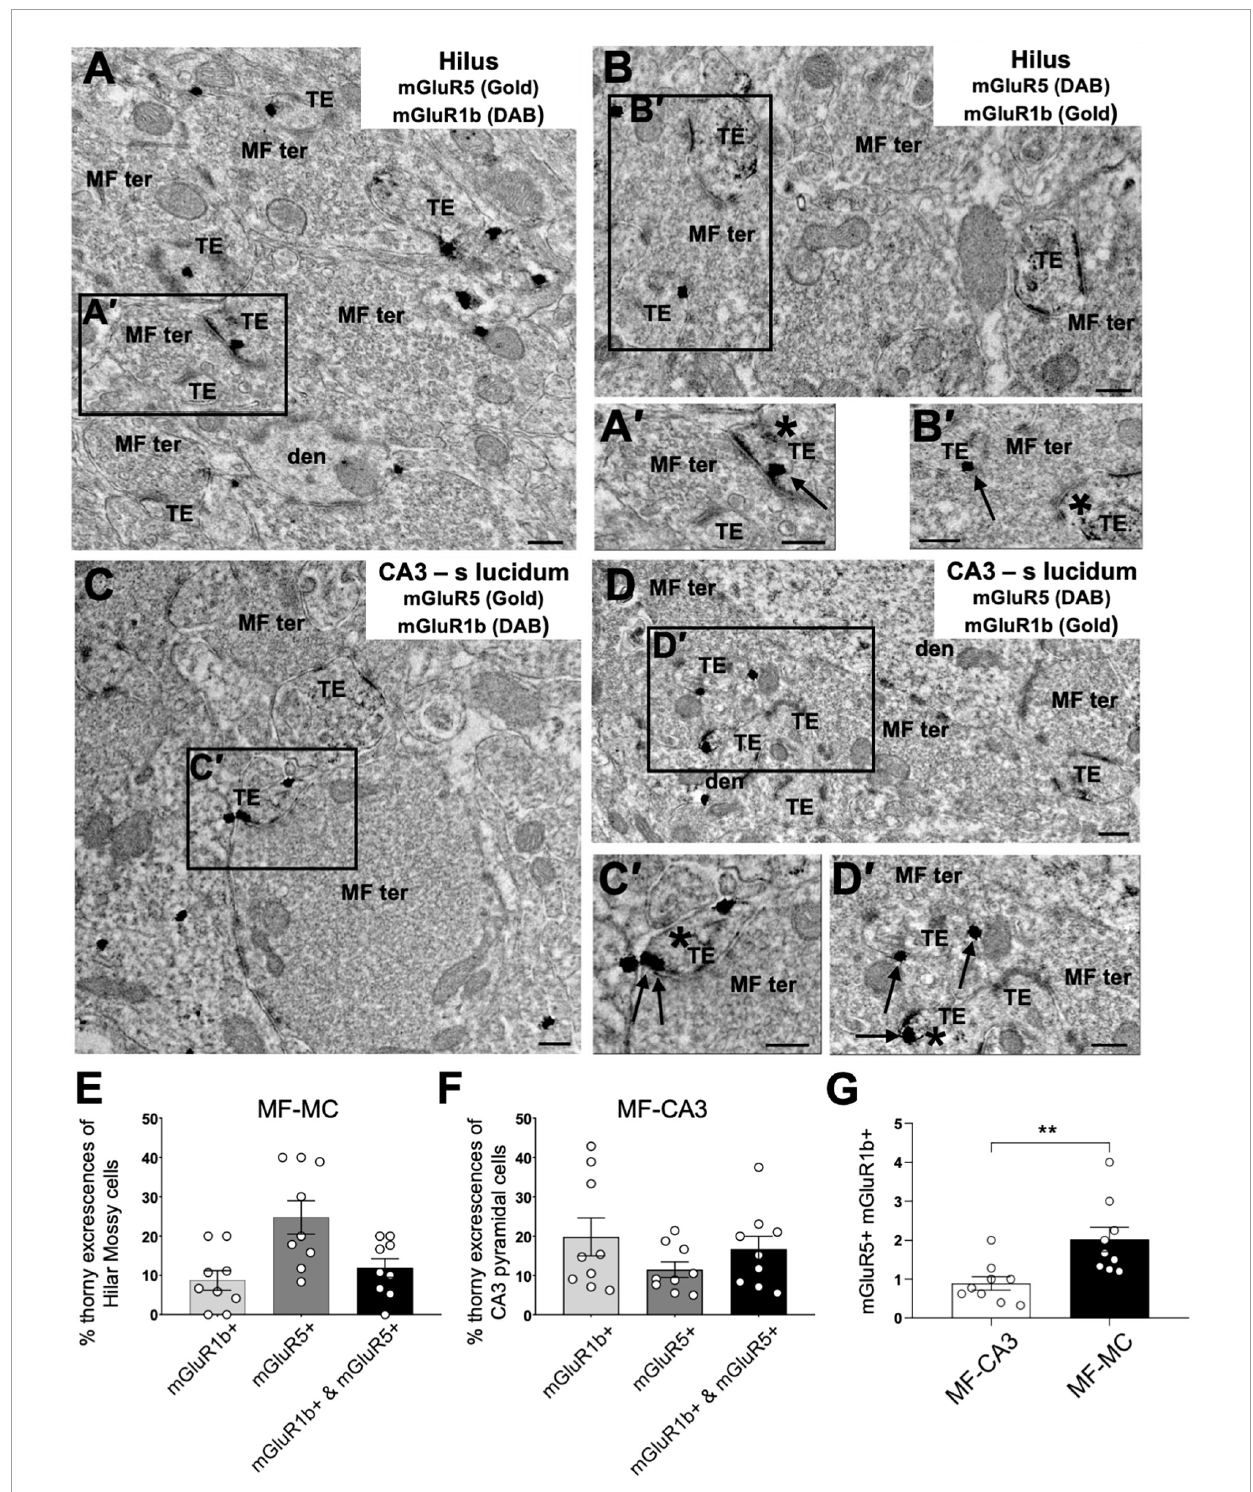
FIGURE6 Immuno–electron microscopy of mGluR1b and mGluR5 at TEs in the hilus and CA3 stratum lucidum of hippocampus. (A–D) Large MF synaptic terminals (MF ter) containing abundant round and clear synaptic vesicles form asymmetric synapses with TEs in dendrites (den) of MCs in the hilus of the dentate gyrus (A,B) and CA3 pyramidal neurons (C,D) . MF synapses [insets (A’,B’) ] contain mGluR1b [asterisk in panel (A’) ; arrow in panel (B’) ] and mGluR5 [arrow in panel (A’) ; asterisk in panel (B’) ] in dendritic TEs found on MCs. TEs of CA3 pyramidal neurons [insets (C’,D’) ] also contain mGluR1b [asterisk in panel (C’) ; arrow in panel (D’) ] and mGluR5 [arrow in panel (C’) ; asterisk in panel (D’) ]. (E,F) Distribution of mGluR1b, mGluR5, or both mGluR1b and mGluR5 in TEs of MCs ( n = 193) and CA3 pyramidal neurons ( n = 158). (G) Ratio of mGluR5/mGluR1b at MF-CA3 and MF-MC synapses, demonstrating a distinct I-mGluR subtype expression at these synapses (** p = 0.0023). All data are expressed as mean ± SEM. Each data point in the bar graphs shows the mean value of the percentage (E,F) or the ratio (G) of each experiment from each animal. Scale bars: 0.25 µ